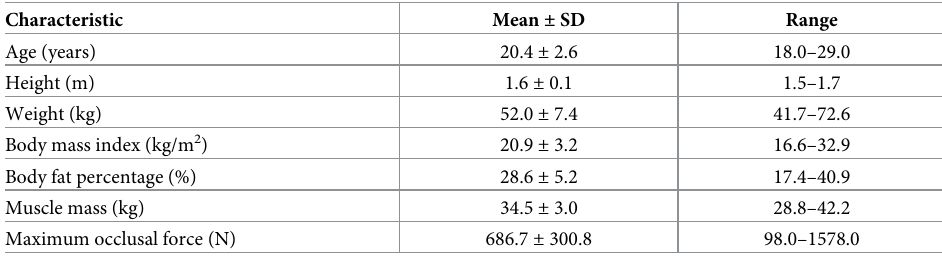
Table 1. Characteristics of the study population (n =